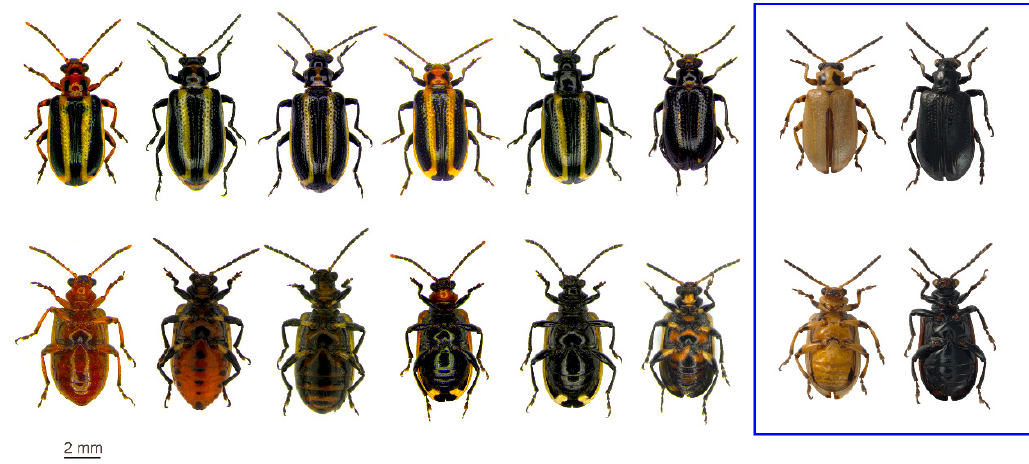
Figure 2. Lema bilineata : main color patterns in Italian specimens and extreme color forms in SANC specimens (within blue frame), in dorsal (upper row) and ventral (lower row) view.